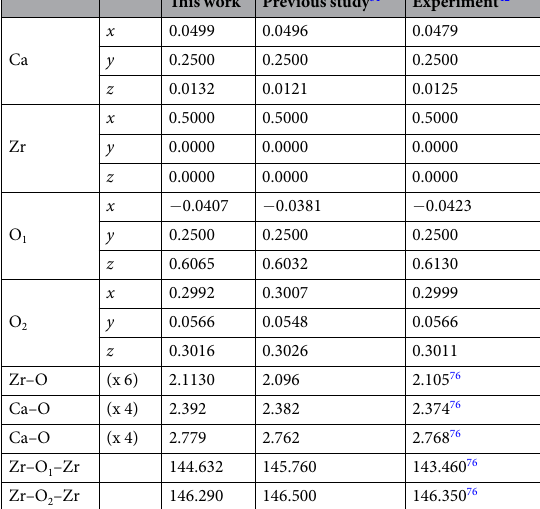
Table 2. Comparison of the calculated and experimental atomic positions, mean bond lengths (Å), and bond angles (degrees) of pristine orthorhombic (space group # 62, Pbnm ) CaZrO 3 .